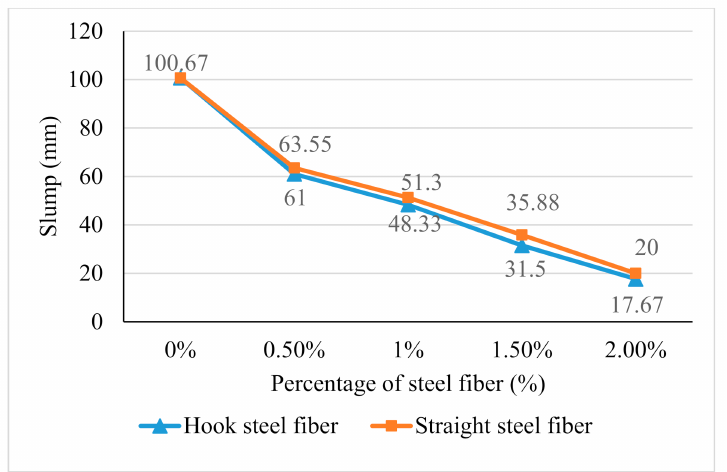
Figure 2. Slump of geopolymer concrete with the addition of hook steel fibers and straight steel